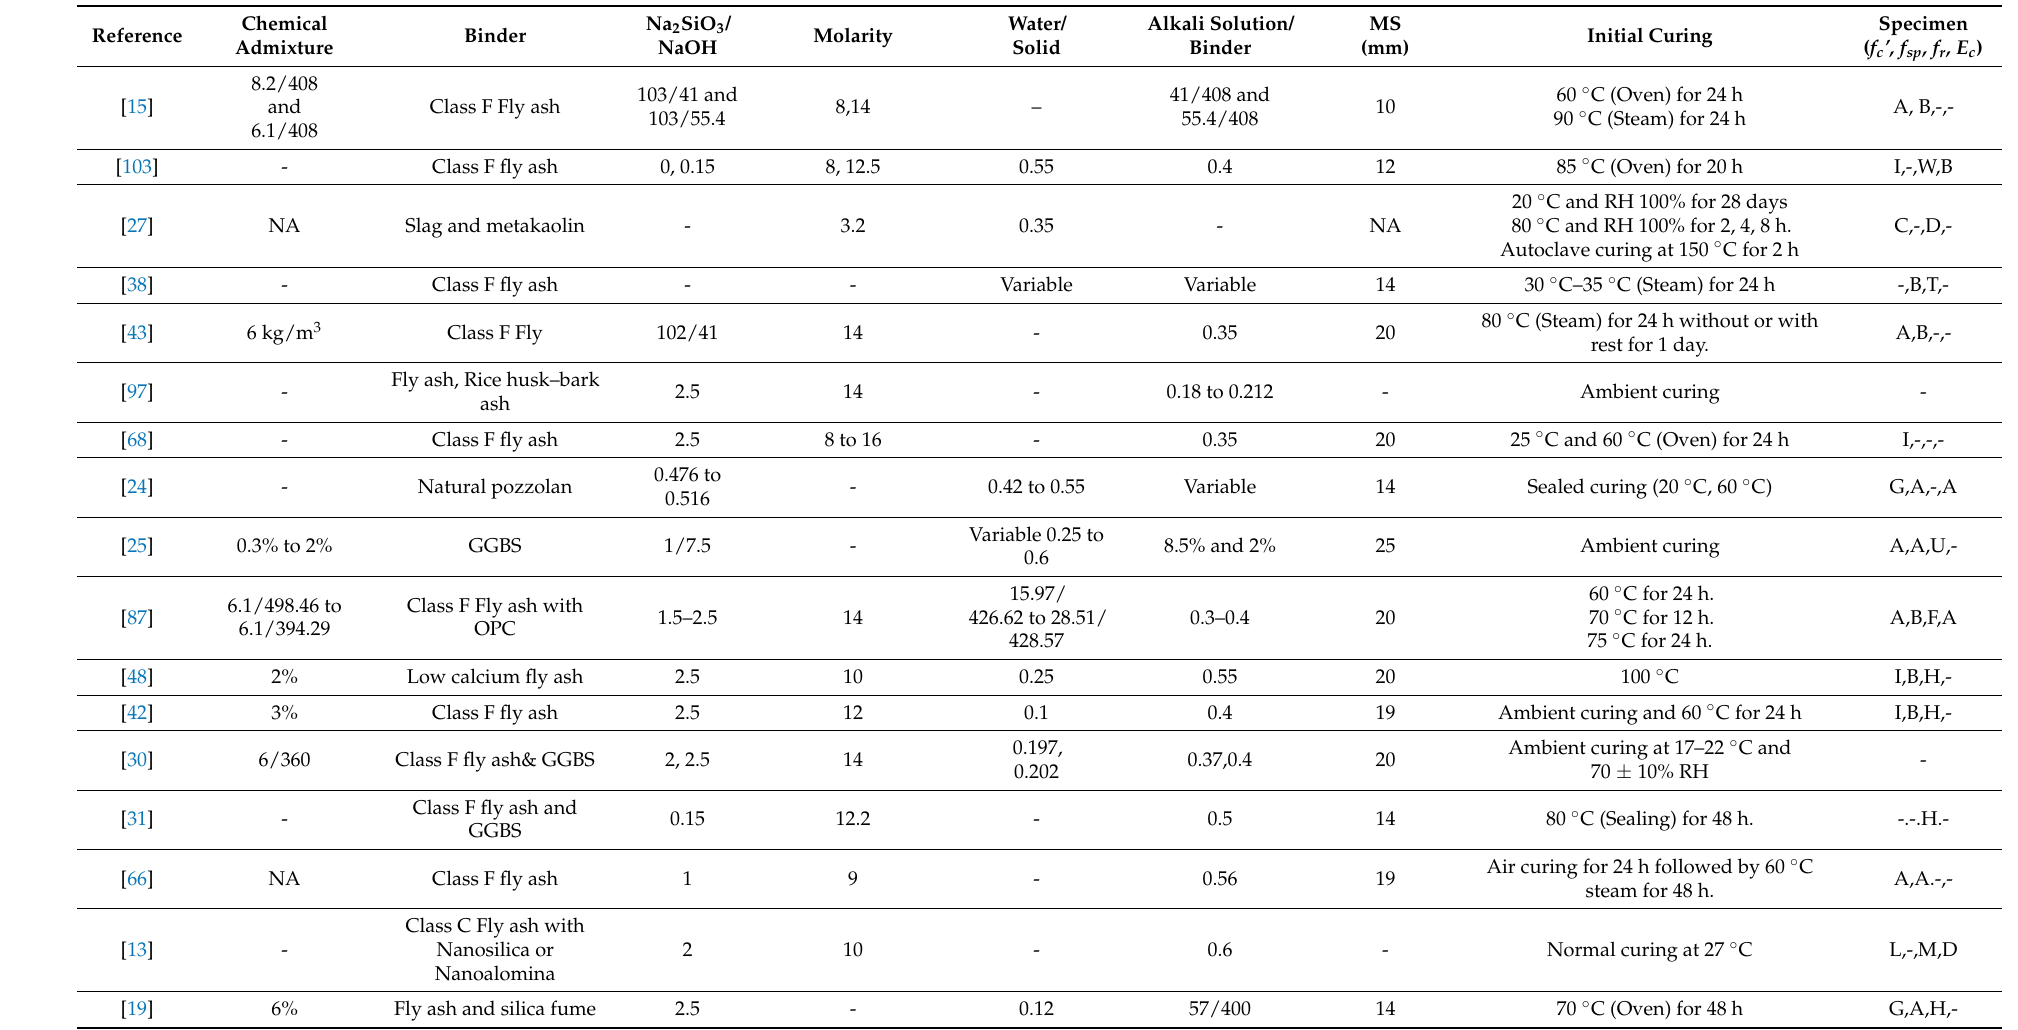
Table 1. Details of test